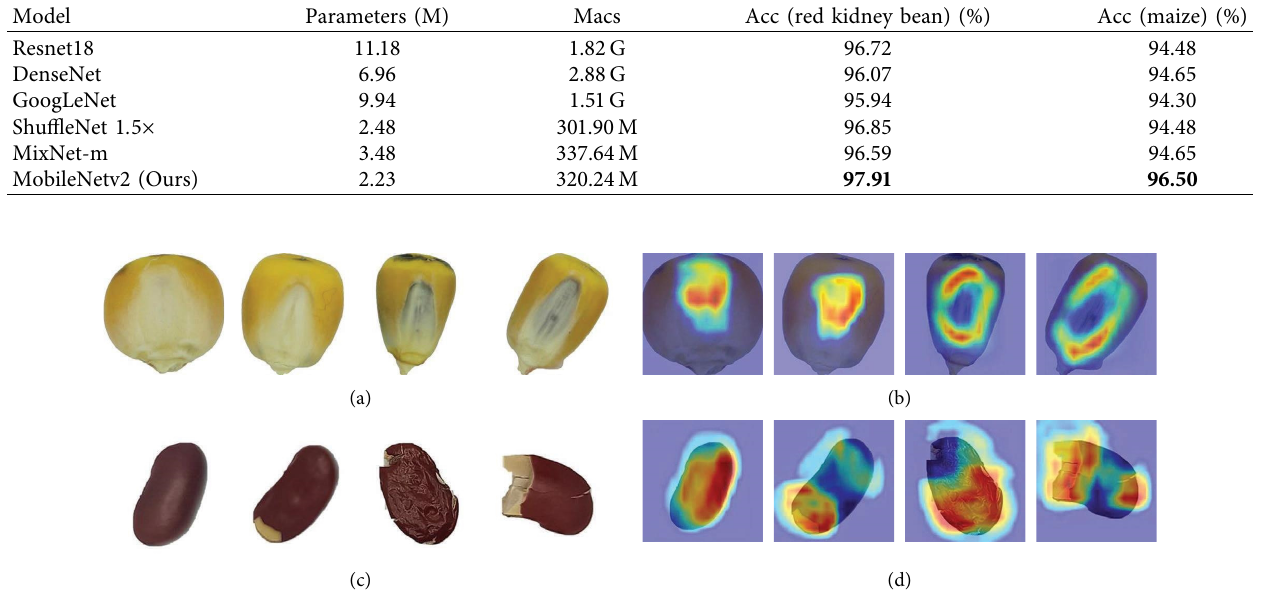
Figure 7: Te comparison of raw images and grad-CAM visualization of seeds on the MobileNetv2 network (a), (c) raw images; and (b), (d) Grad-CAM visualization.